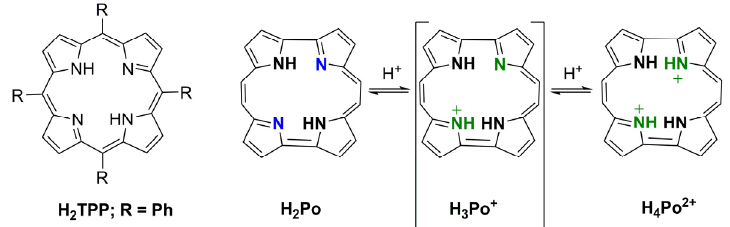
Figure 1. Comparison of meso-tetraphenylporphyrin (H 2 TPP) and porphycene (H 2 Po) molecular structures; the protonation of porphycene (H 3 Po + , H 4 Po 2+ ) is